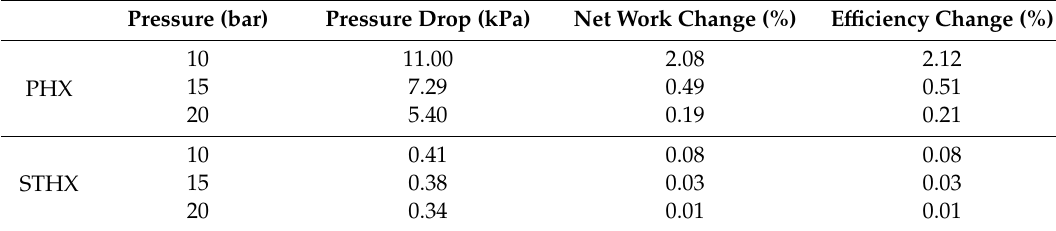
Table4. Pressuredropintheheatexchangersandthecorrespondingreductioninnetworkande ffi